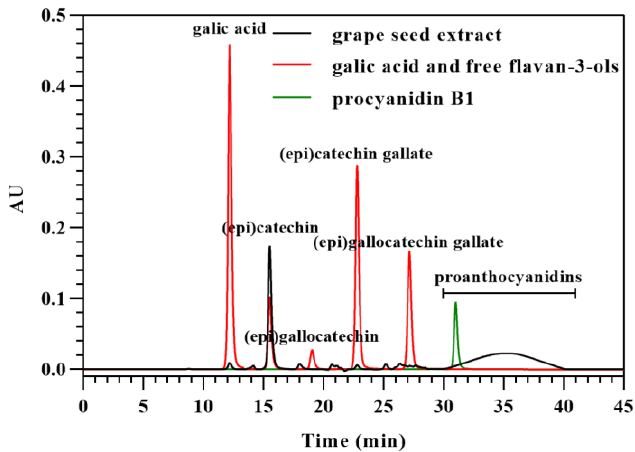
Figure 5. HPLC chromatograms of grape seed extract, free flavan-3-ols, and procyanidin B1, which were analyzed with HILIC based on their molecular weight.